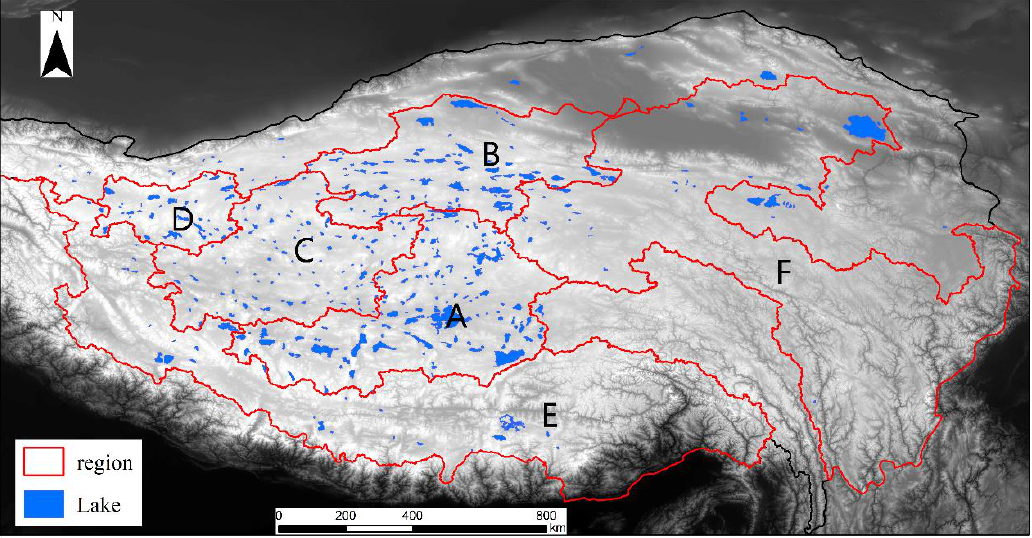
Figure 6. Watershed division and spatial distribution of lakes on the TP, and regions of A–F represent different sub-regions of this study based on changing characteristic of lakes.